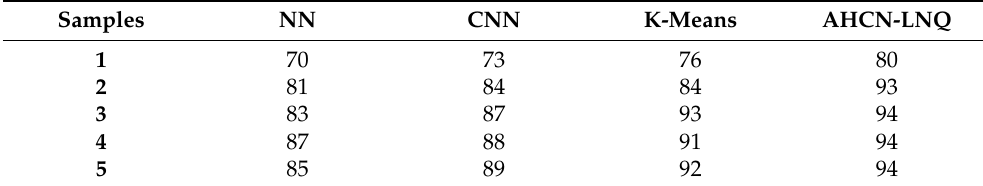
Figure 7. Comparison of specificity. Table 2. Sample rate calculation on basis of recognition rate.